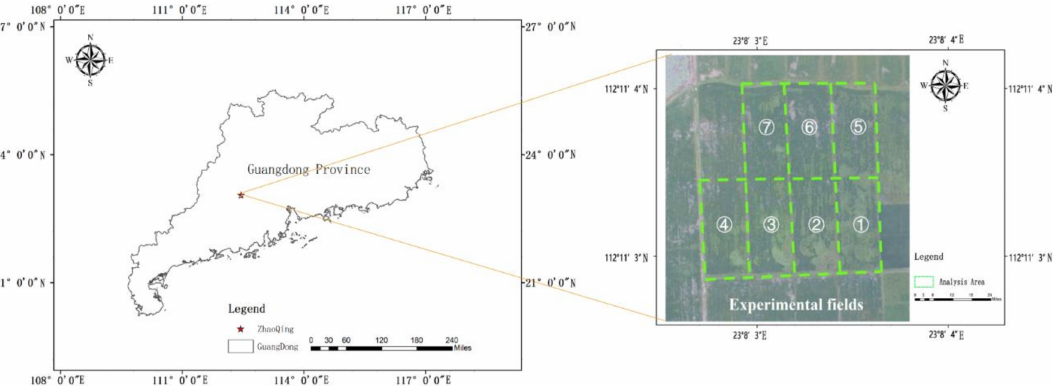
Figure 2. UAV remote sensing image collection area.